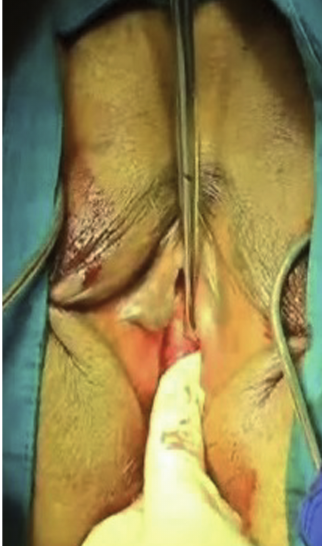
Figure 2 - The needle is pushed until it reaches 1.5cm below the urethral meatus (right).